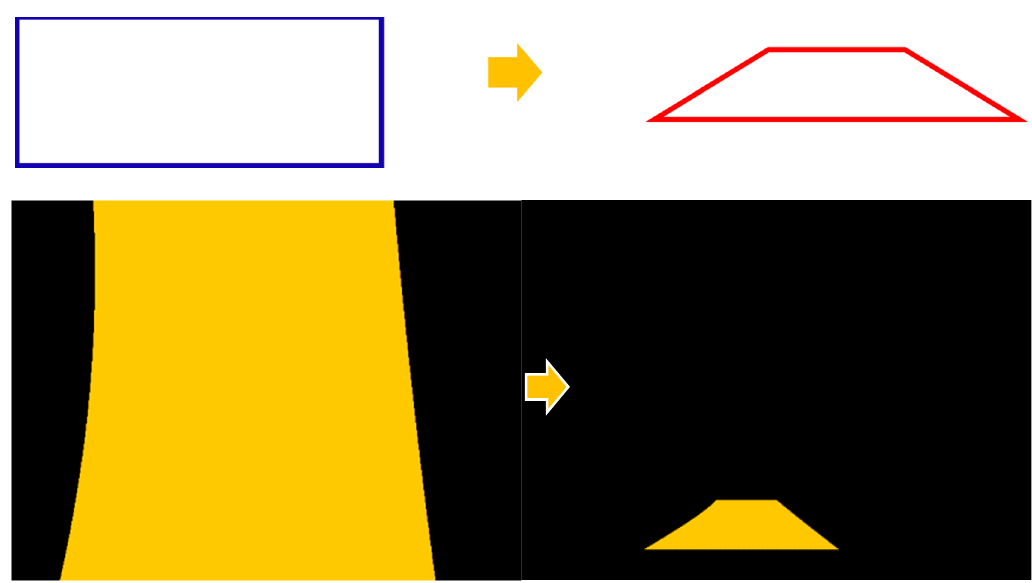
Figure 15. The projection transformation of the lane area.